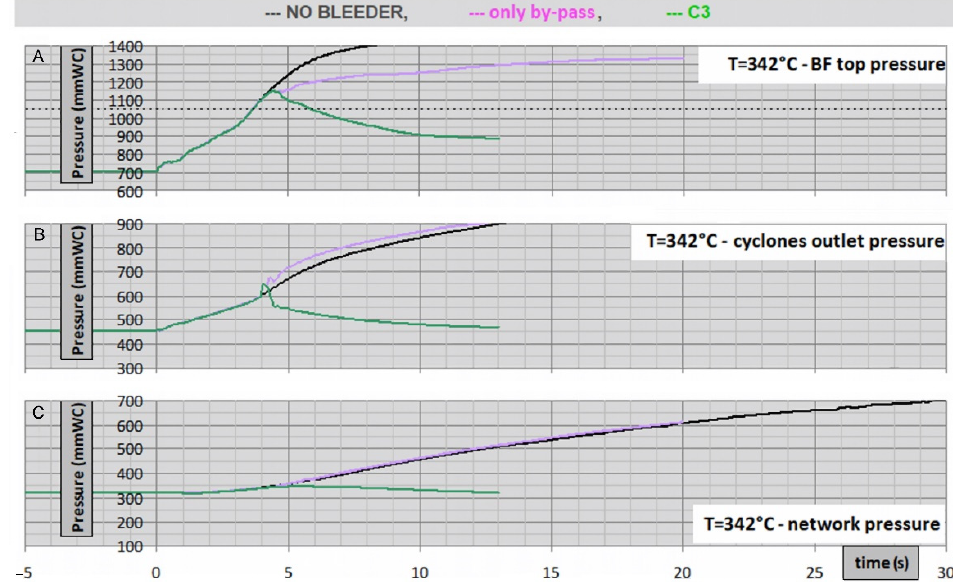
Figure 20. Evolution over time of pressure in the circuit with by-pass opening at 850 mmWC without Clean Relief Valve and C3 compared with the no bleeders case in a high severity event. ( A ) BF top pressure; ( B ) cyclones outlet pressure; ( C ) network pressure.